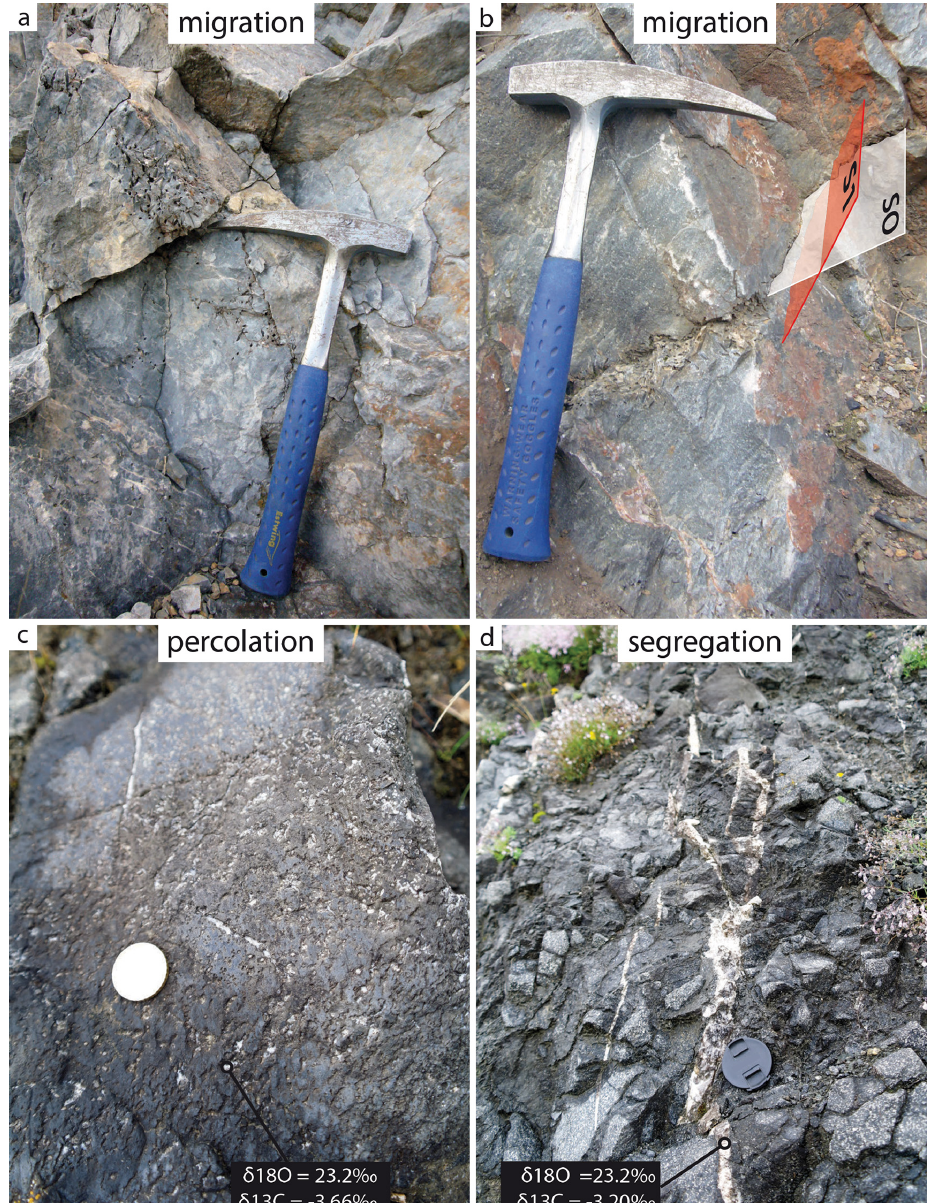
Figure 14. Top: Field indications of fluid circulations in the Urgonian marbles near Estagel (Bas-Agly syncline). Centimeter-long scapolite ghosts are found in the immediate vicinity of fractures (a) or interbeds (b) . Note that the former scapolite crystals show no preferential orientation, whereas the marble presents a clear ductile foliation responsible for the stretching and flattening of fossils. In this case, the fluid circulation hence postdates the main hot deformation event. Bottom: Percolation (c) and segregation (d) of fluids in the Triassic meta- evaporites of the Col d’Agnes (Aulus basin). Such meta-evaporitic material is a potential source of Na- and Cl-rich fluids responsible for the precipitation of